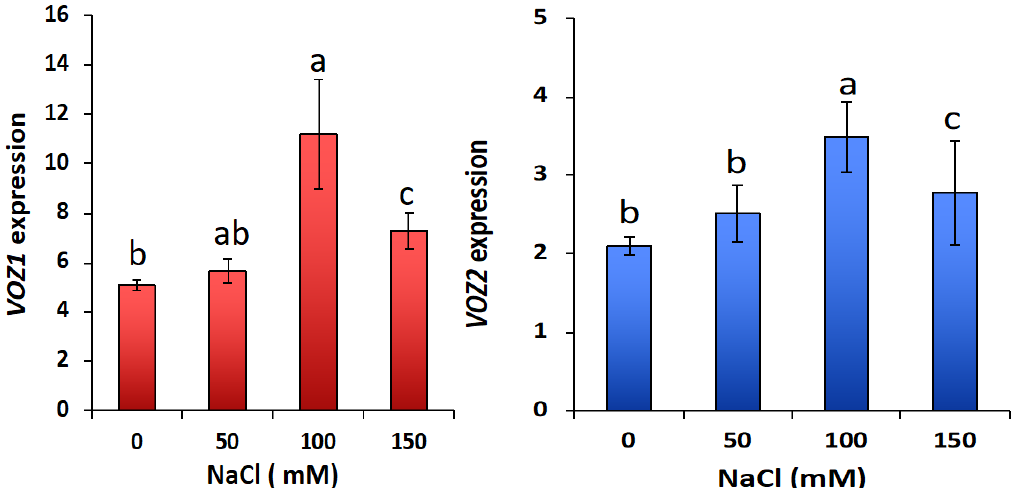
Figure 8. Expression of VOZs in response to salt stress. Expression of VOZ1 (top panel) and VOZ2 (bottom panel) in 10-day-old seedlings of WT seedlings grown on 1/2 MS medium supplemented with 0, 50, 100 or 150 mM NaCl was determined by RT-qPCR. The expression of VOZs was normalized with ACTIN2 .